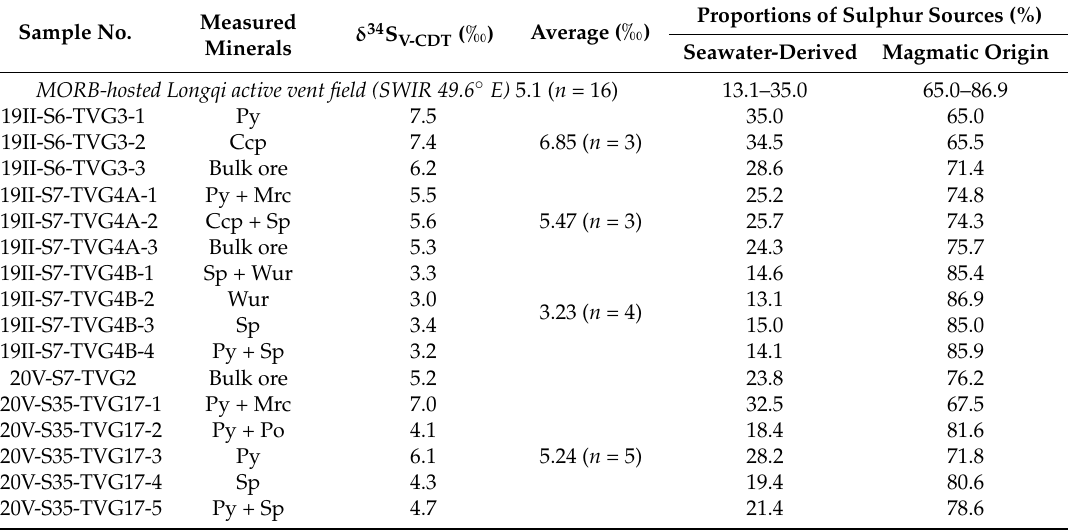
Table 3. Bulk S-isotope compositions of polymetallic massive sulphides from the Mid-Ocean Ridge hydrothermal vent systems and the estimated proportional contributions of dual sulphur sources. * Sample